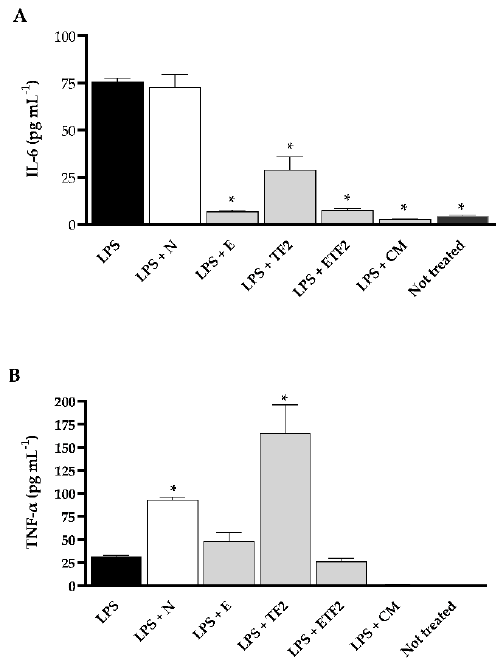
Figure 4. Evaluation of pro-inflammatory cytokine production by bone-marrow-derived macrophages (BMDMs). Expression of interleukin-6 (IL-6) lipopolysaccharide (LPS)-induced ( A ) and tumor necrosis factor-alpha (TNF- α ) LPS-induced ( B ) production in BMDMs supernatants culture after treatment with N: formulation without fluoride (F), sodium trimetaphosphate (TMP) and pomegranate peel extract (PPE); E: formulation with 3% PPE; TF2: formulation with 0.3% TMP + 225 ppm F; ETF2: formulation with 3% PPE + 0.3% TMP + 225 ppm F; CM: essential oil commercial mouthwash for 2 h. “Not treated” denotes cells that were not stimulated with LPS. ( A ) IL-6 and ( B ) TNF- α concentrations in culture supernatants were measured in triplicate using an ELISA assay. Data were pooled from representative of three independent experiments (mean ± SD). Asterisks indicate statistical significance regarding cells stimulated only with LPS, ( A ) p ≤ 0.001 and ( B ) p ≤ 0.05 (one-way ANOVA followed by the Tukey multiple comparisons